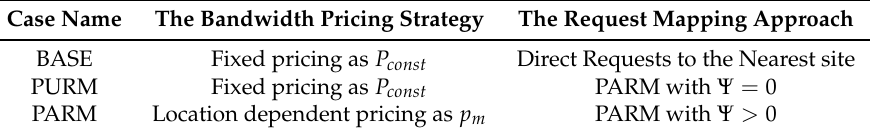
Table 4. Details of the compared cases.